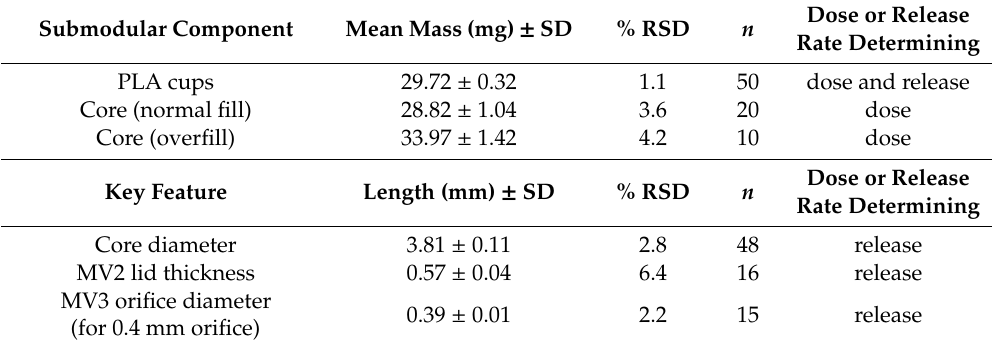
Table 1. Mass and measured dimensions of submodular components governing dose and drug